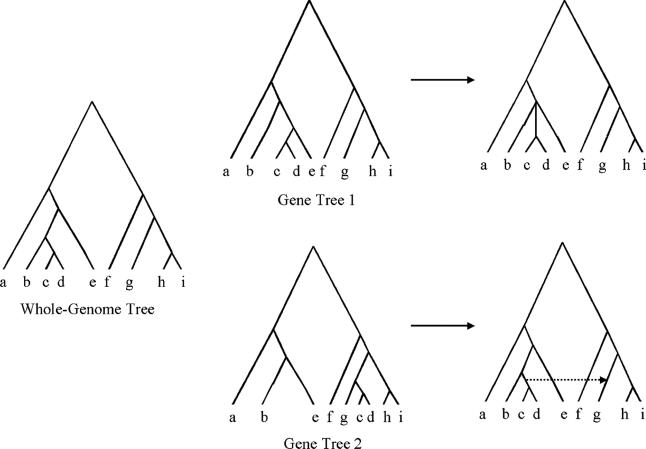
HGT Inference via Tree ComparisonRaw difference between the SD and the MAST metrics for a given pair of trees tends to increase when HGT is involved in one tree. For example, the raw SD and MAST scores for Gene Tree 1 and the W-G tree are 2 and 2, respectively, while the SD and MAST scores for Gene Tree 2 and the W-G tree are 8 and 2, respectively. This difference between the SD and the MAST scores indicates possible HGT in Gene Tree 2; the (c and d) clade are transferred to the g lineage (dotted arrow). In Gene Tree 1, the (c and d) clade cannot be inferred as transfers because many other factors could have caused the local uncertainty in branching, which should be presented in polytomous form.